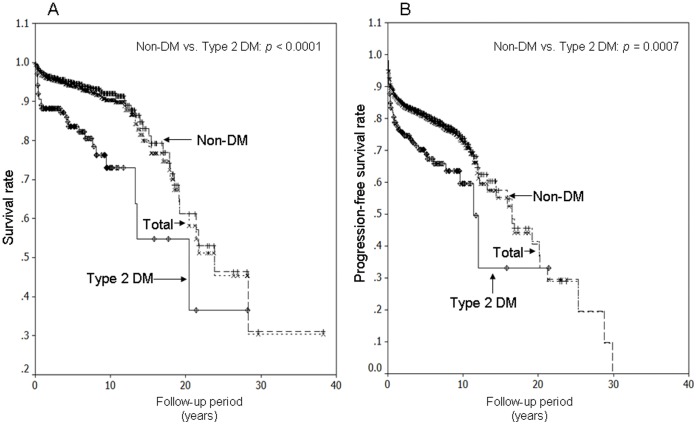
Cancer-specific and postoperative non-progressive survival curves.Cancer-specific survival curves for patients with type 2 diabetes mellitus (DM), patients without DM (non-DM), and all patients (A). Postoperative non-progressive survival rates for patients with type 2 DM, patients without DM (non-DM), and all patients (B).